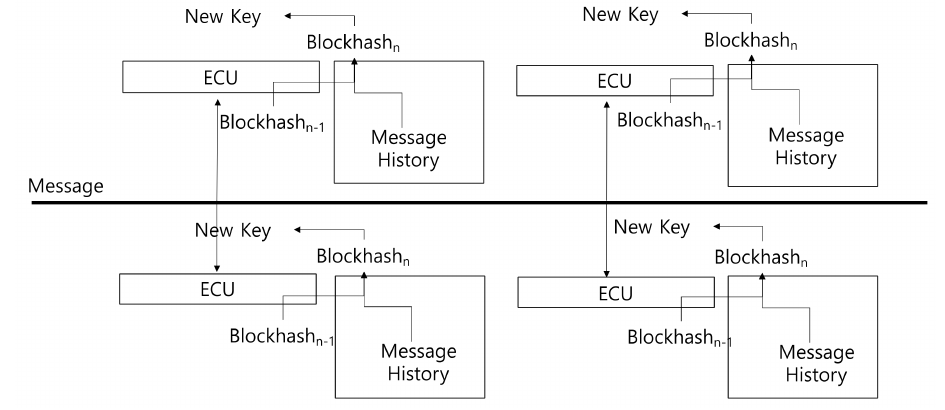
Figure 3. History-based encryption key